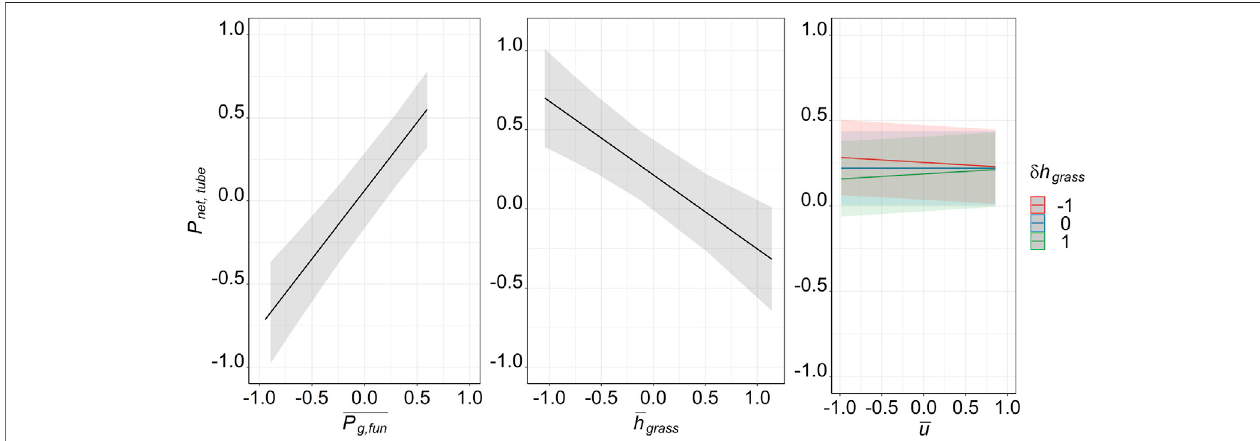
FIGURE11| Visualisationofthesigni fi cantrelationsshownin Figure10 ,representingthesigni fi cantdriversofthenetprecipitationmeasurements(P net , tube )during the covered period. Relation to (left) mean gross precipitation ( P g , fun ), (center) average grass height ( h grass ) with P net , tube . (right) Interactive relation of mean wind speed ( (cid:1) u ) , and the spatial deviation of grass height δ h grass with P net , tube .